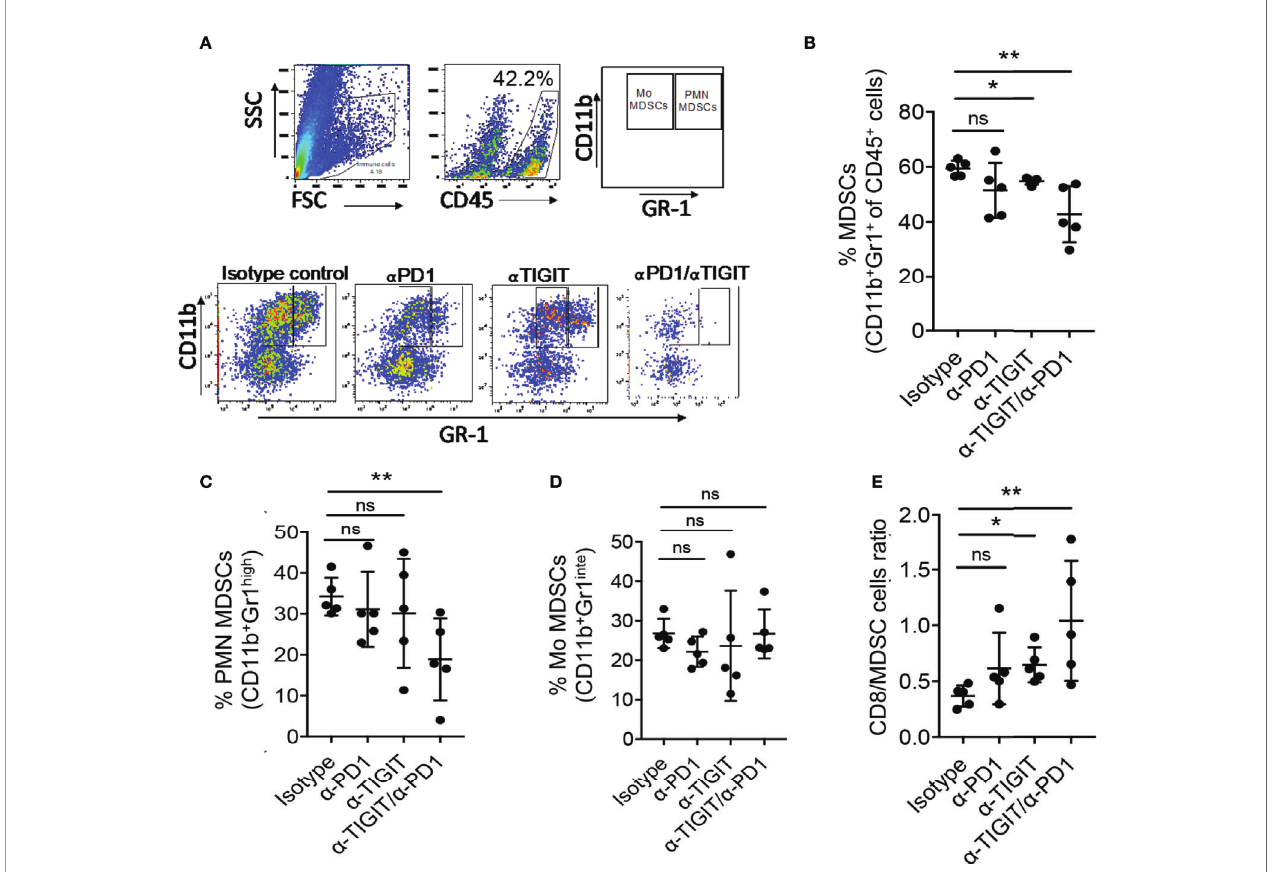
FIGURE 5 | Anti-PD1/TIGIT immunotherapy is associated with altered myeloid-derived suppressor cells (MDSCs) in GL261 murine model. GL261 glioma cells were injected stereotactically in the caudate putamen of C56BL/6J mice followed by immunotherapy treatment starting on day 8 post tumor injection, and the frequencies of MDSCs were determined on day 22. (A) Representative fl ow cytometry plots showing gating strategy of PMN MDCSs and Mo MDCSs based on the expression of Gr1 and CD11b. (B – D) Percentages (%) of CD45 + glioma-in fi ltrating total MDSCs (CD11b + Gr1 + ) (B) , PMN MDSCs (CD11b + Gr1 high ) (C) , and Mo MDSCs (CD11b + Gr1 low ) (D) , on day 22 following treatment. (E) Ratios of tumor in fi ltrating CD8+ T cell to total MDSCs. Representative data of 3 experiments. n=5 per group. One-way ANOVA with multiple comparisons test corrected for false discovery rate (FDR) using Benjamini-Hochberg test. P values are as followed: * ≤ 0.05, ** ≤ 0.01, NS, not signi fi